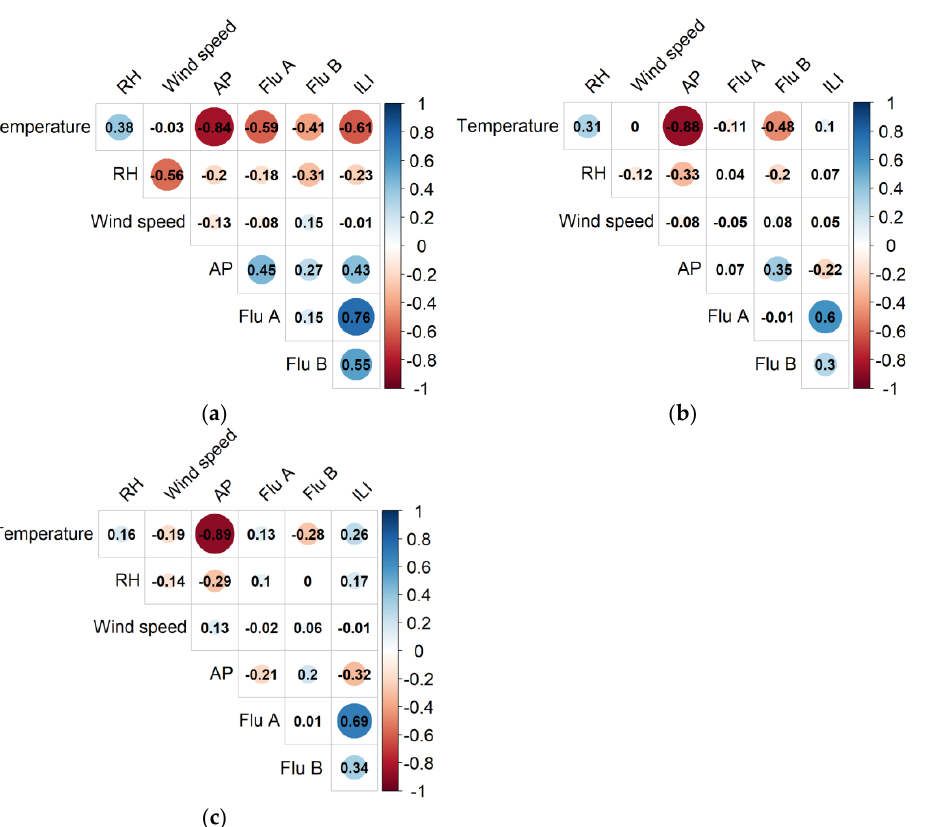
Figure 3. Results of Spearman’s rank correlation analysis between ILI/Flu A/Flu B and meteorolog- ical factors. ( a ) Northern China; ( b ) Central China; ( c ) Southern China. The numbers in the figure are Spearman’s rank correlation coefficients. A darker circle indicates a larger absolute value of the coefficient. Two variables with insignificant correlations are represented by blanks. Abbreviation s : ILI, influenza-like illness; Flu A, influenza A; Flu B, influenza B; RH, relative humidity; AP, air pres- sure.